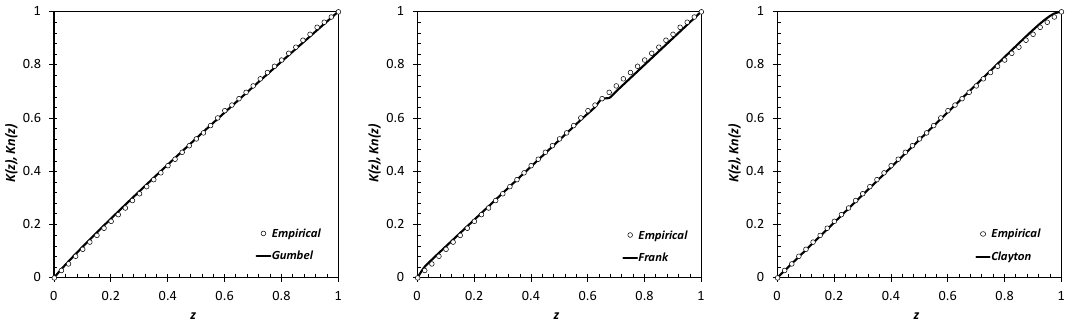
2 3 Figure 12. K plot for the copula models. The “empirical” points represent the pairs coming from the R–R model.